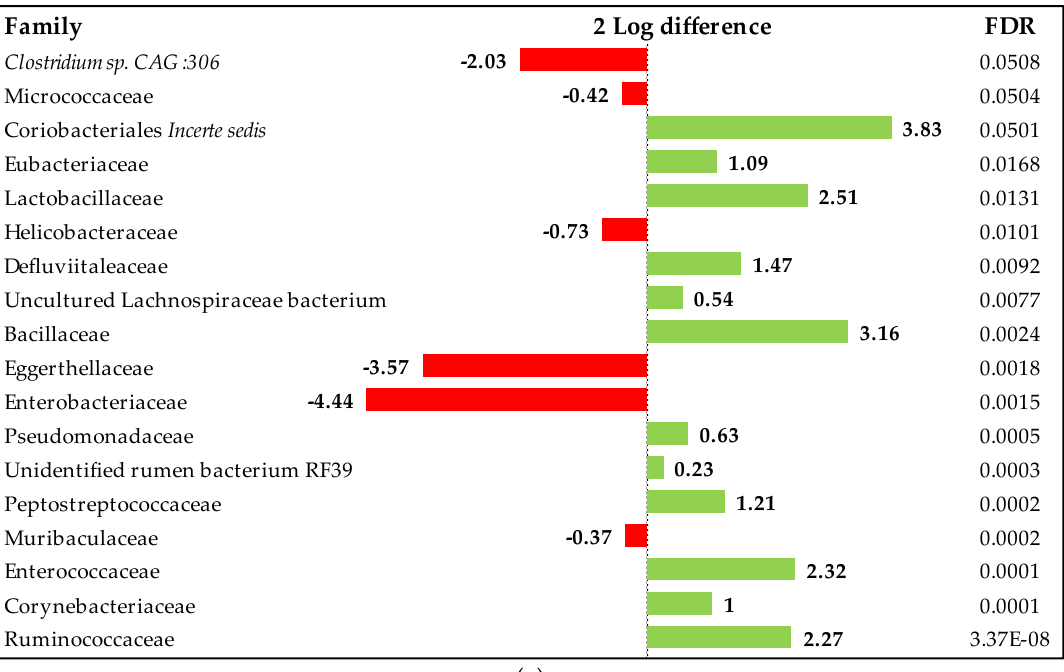
Figure 7. Relative abundance (%) of the main phyla ( a ), families ( b ), and genera ( c ) present in the cecum microbiota of broiler chickens at d42 of age (Trial 2). NC: Negative control; OA2: Calcium butyrate + fumaric acid; OA3: Calcium butyrate + fumaric acid + citric acid + MCFA; MCFA: Capric-caprylic acid + caproic acid + lauric acid; AC: Cinnamaldehyde, carvacrol, and thymol as major compounds; PC: Positive control.